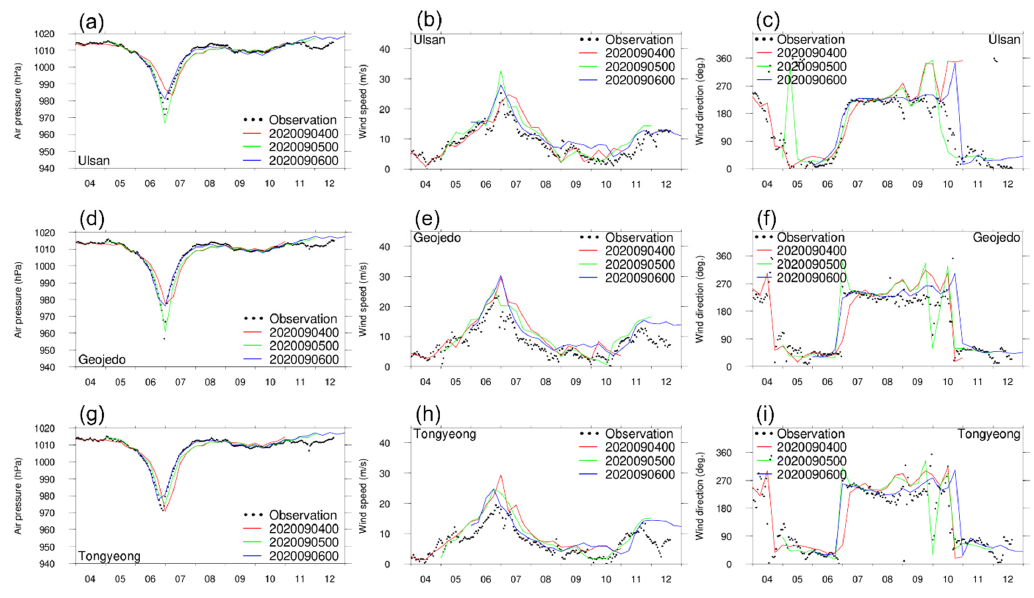
Figure 6. Comparison of the MPAS forecast with the observations (Ulsan, Geojedo, and Tongyeong) for the case of Haishen in 2020. ( a , d , g ) surface pressure (hPa); ( b , e , h ) wind speed (m/s); ( c , f , i ) wind direction (degree). Here, the x -axis indicates the time with the date of the simulation period, and the interval of observation data is one